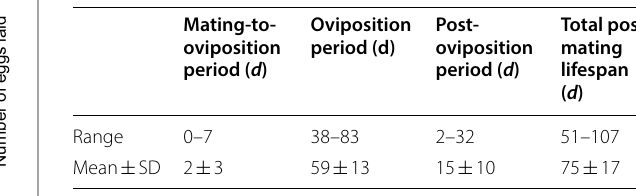
SD standard deviation